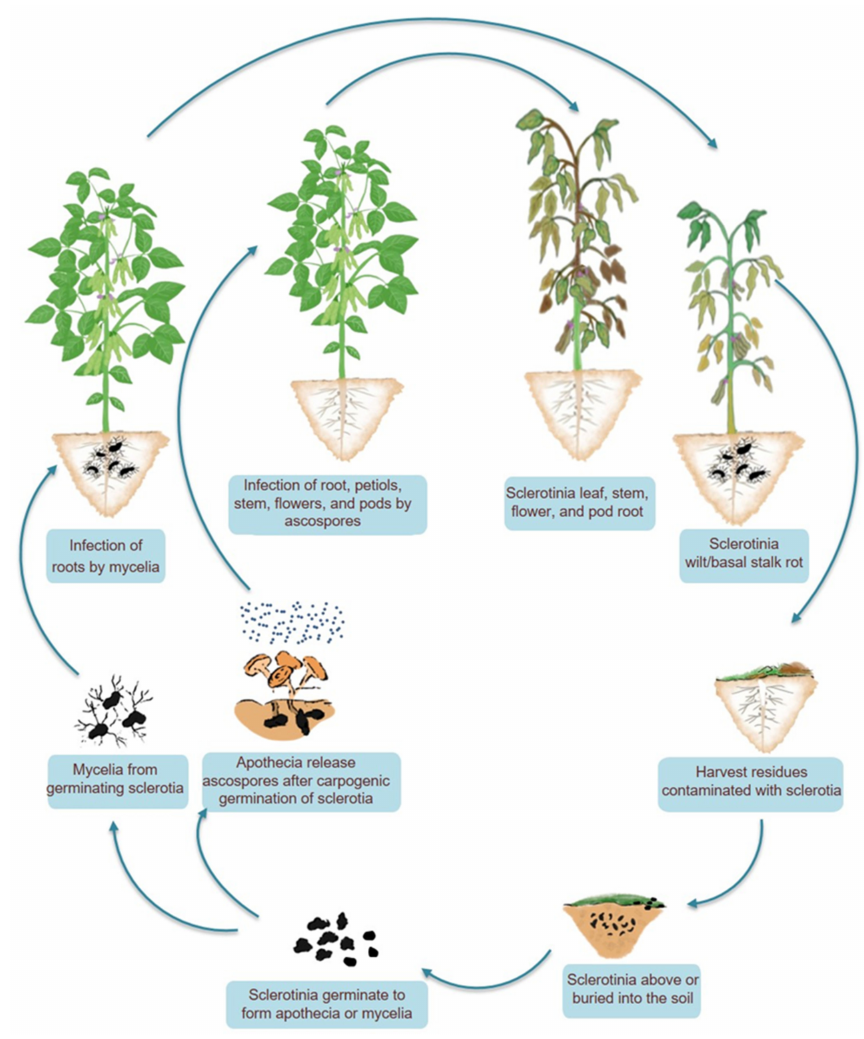
Figure 2. Life cycle and signs of infection of Sclerotinia sclerotiorum in soybean. The fungus has a monocyclic life cycle and does not produce secondary inoculum. It forms a survival structure known